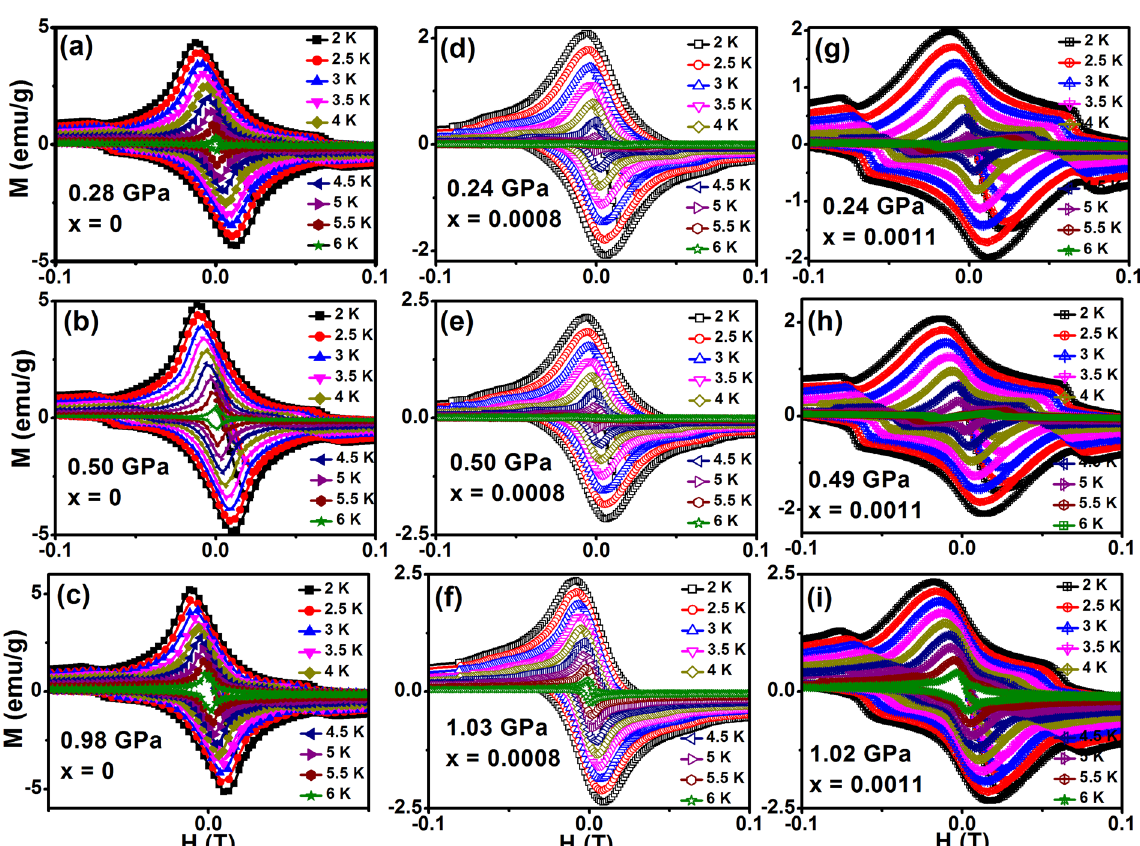
Figure 4. Field dependent isothermal magnetization curves of the ( a – c ) NbSe 2 , ( d – f ) Fe 0.0008 NbSe 2 and ( g – i ) Fe 0.0011 NbSe 2 at different temperatures for various hydrostatic